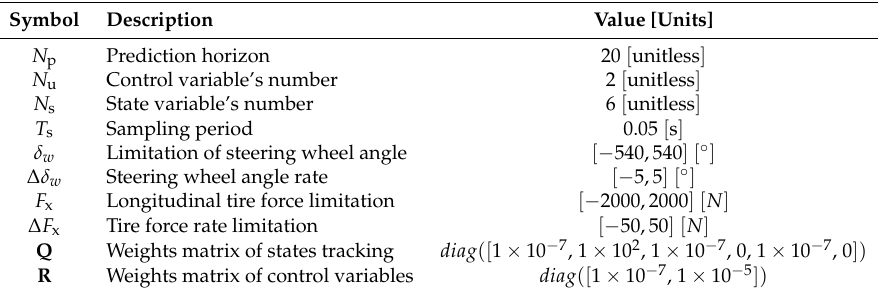
Table 3. Parameters of the MPC Controller.